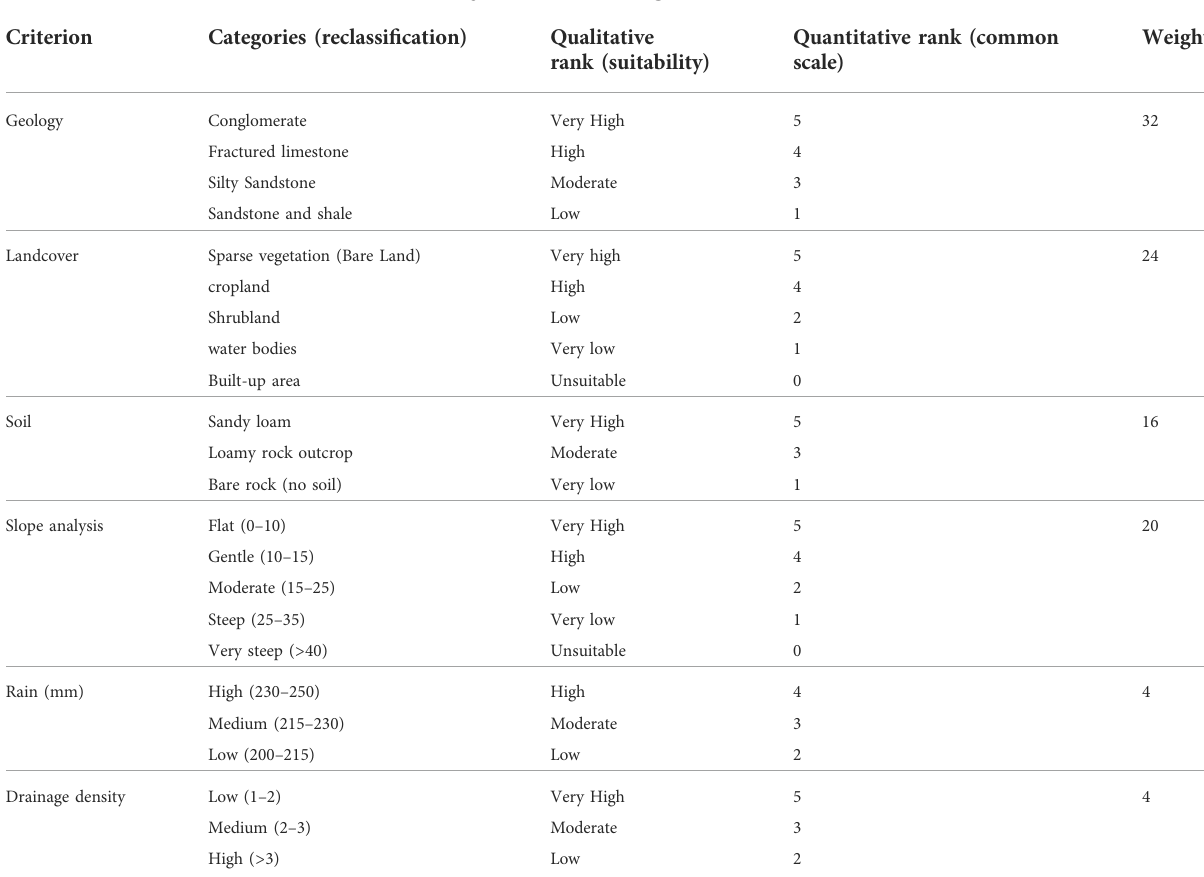
TABLE 4 Criteria reclassi fi cation and associated suitability score (rank) and